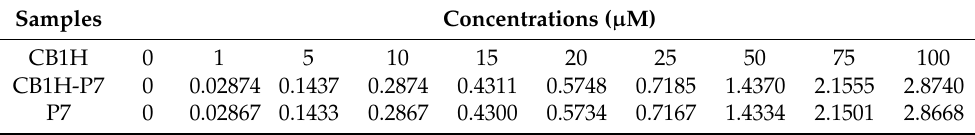
Table 2. Concentrations of each sample administered to HaCaT cells (24 h